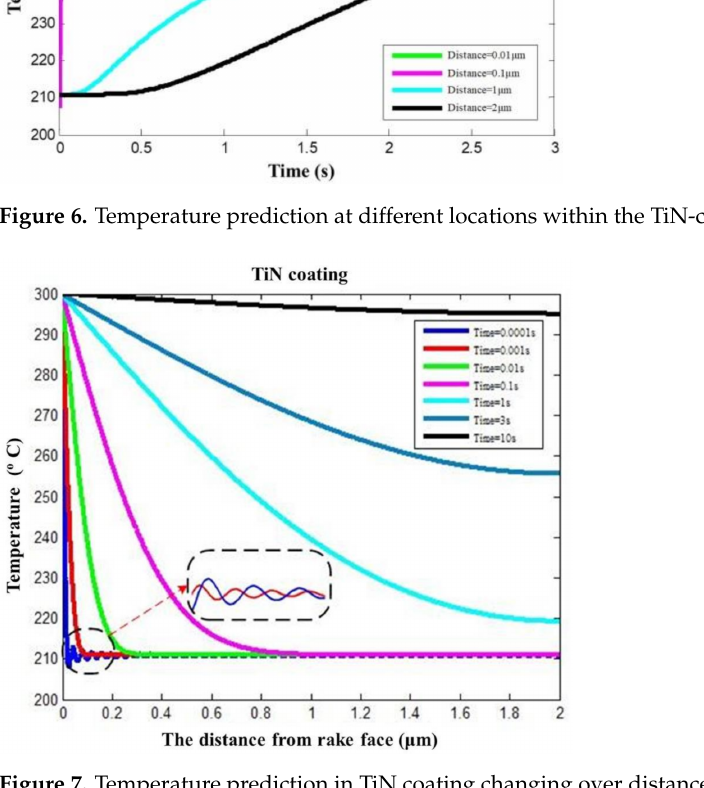
Figure 7. Temperature prediction in TiN coating changing over distance from coating